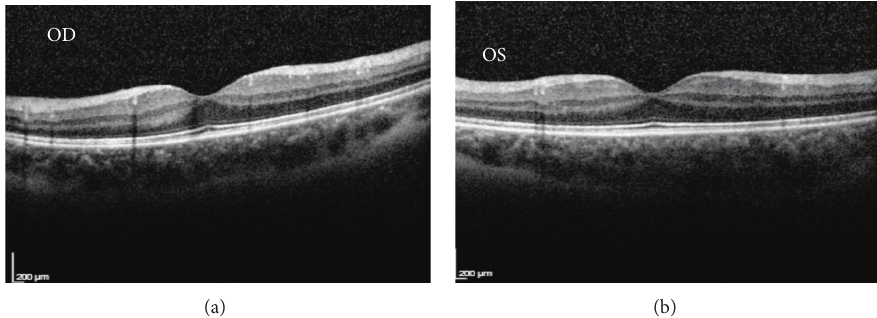
Figure 2: Optical coherence tomography of the macula without any abnormal findings.